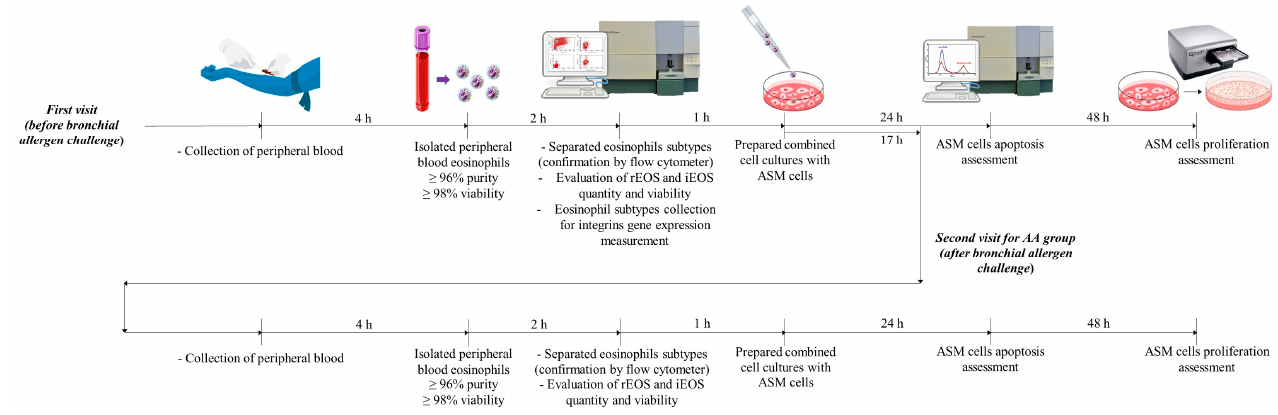
Figure 2. Experiment plan. AA, allergic asthma; ASM, airway smooth muscle; iEOS, inflammatory eosinophils; rEOS, lung-resident